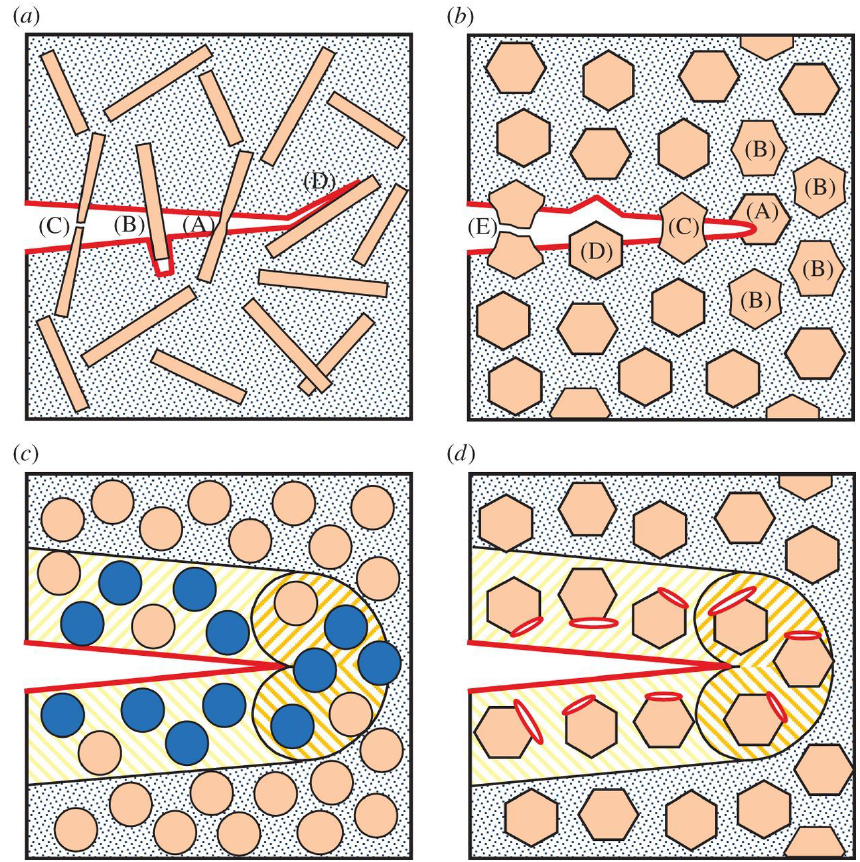
Figure 4: (a) The transformation of the tetragonal phase into the monoclinic phase; (b) Microcrack toughening